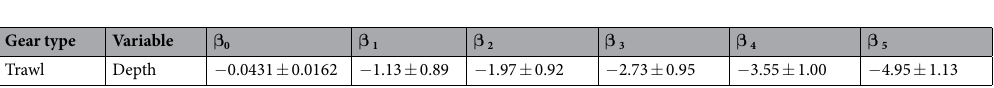
Figure 3. Model fit of the probability of gas embolism score (S1, very mild, to S5, severe) in bycaught turtles against trawling depth. Note that graph initiates at 20 m depth. The shaded gray area indicates expected mortalities in untreated turtles based on previously observed outcomes 16